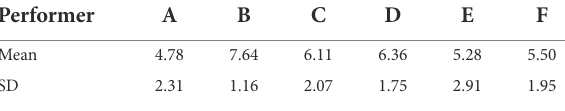
TABLE 4 Overall rating on